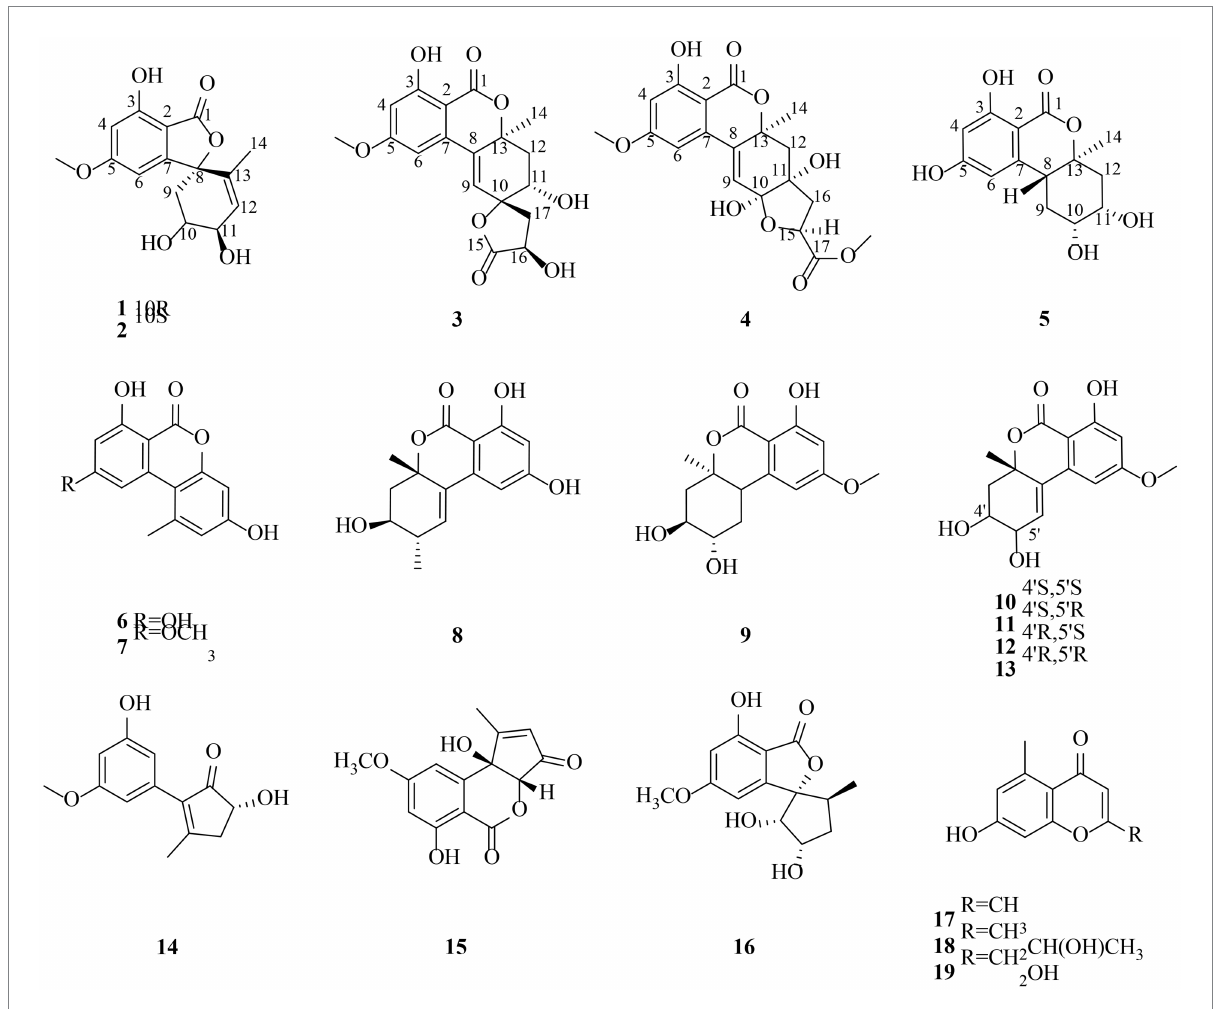
FIGURE 1 Structures of compounds 1–19 .